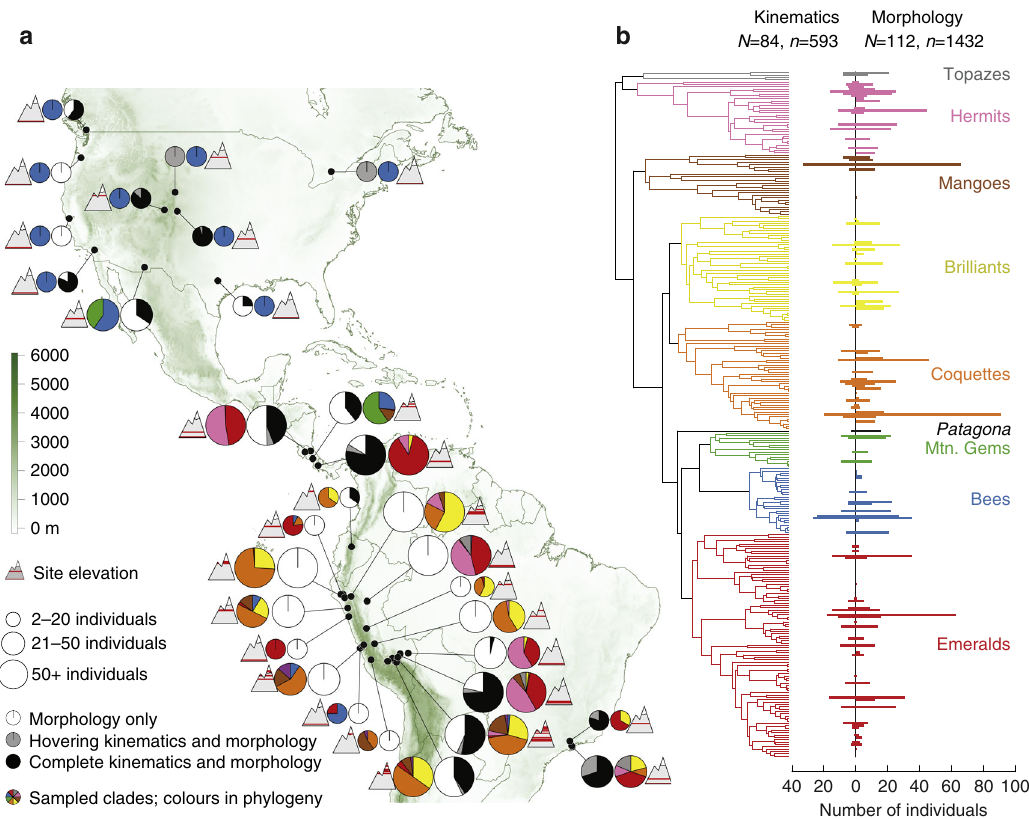
Fig. 1 Biogeographic and phylogenetic sampling of hummingbirds. a Individual collection sites, grouping nearby sites in 5°×5° cells, along with the relative collection site elevation, biodiversity, and type of collected data (morphology, hovering kinematics, or hovering and load lifting kinematics). Colours in pie charts correspond to the colour scheme denoting humming bird clades in b. b All major clades of hummingbirds (de fi ned by McGuire et al. 20 ) were sampled both for kinematic and morphological parameters, though sampling effort varied widely across species and data (Supplementary Fig. 3, ‘ Methods ’ ). Clade-wise examination of allometric exponents broadly con fi rms that the allometries we report are neither dominated by a single clade nor the result of averaging over many different clade-speci fi c force-generating strategies (Supplementary Fig. 4).